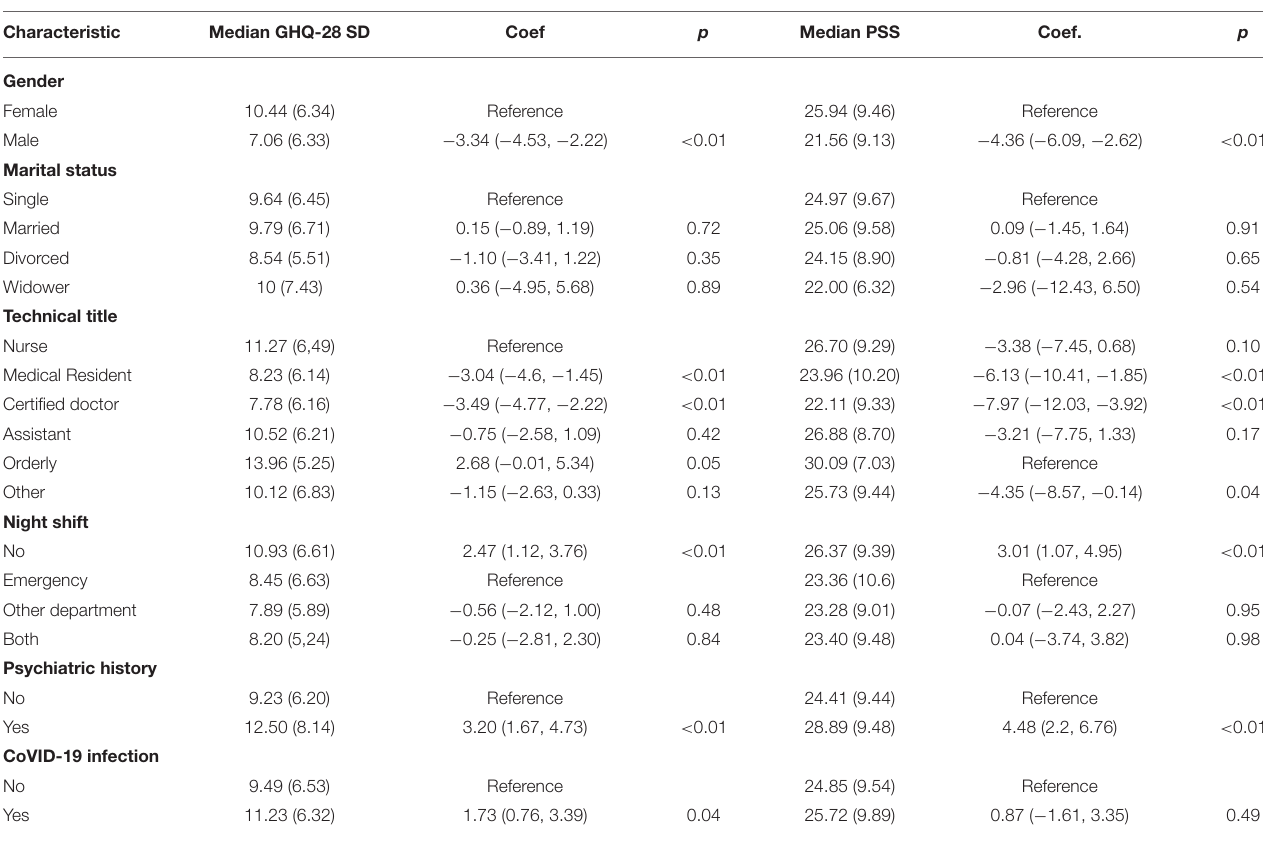
TABLE 4 | Multivariant Regression